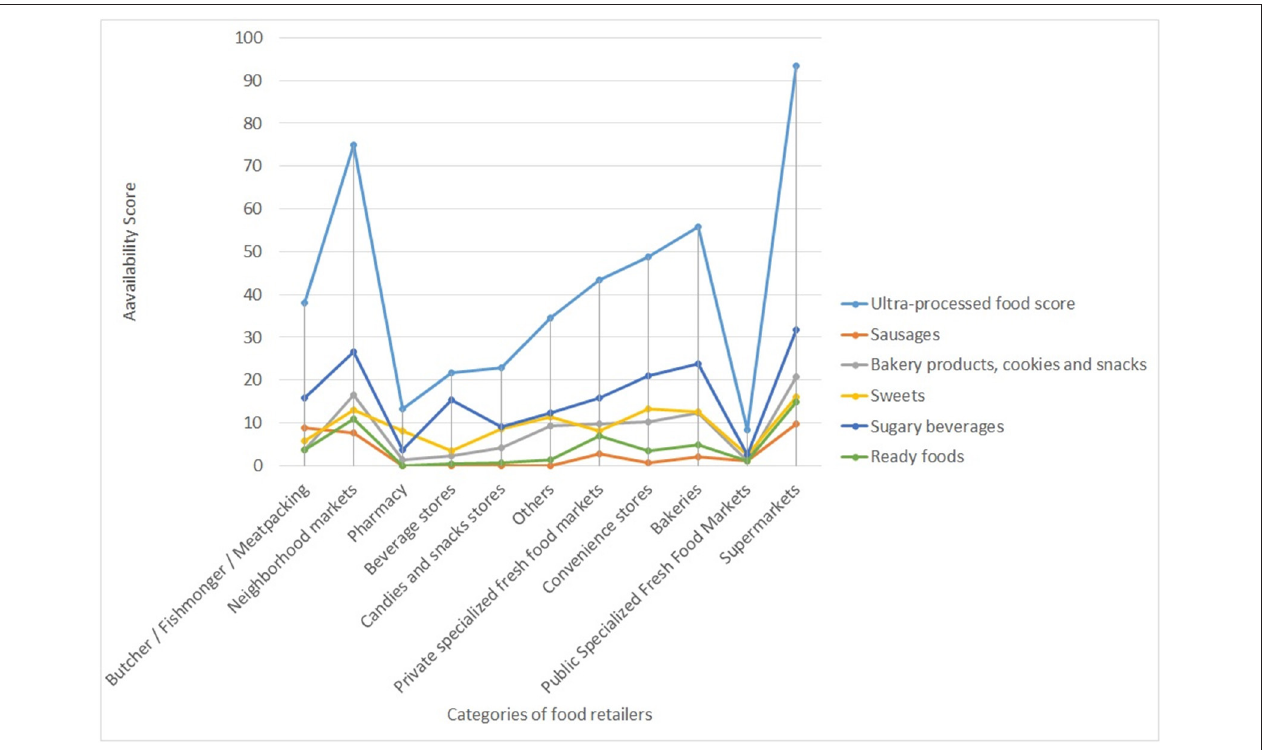
FIGURE 1 | Mean score of the ultra-processed food subcategories availability according to different types of food retailers. Jundiaí, SP, Brazil, 2017–2018.